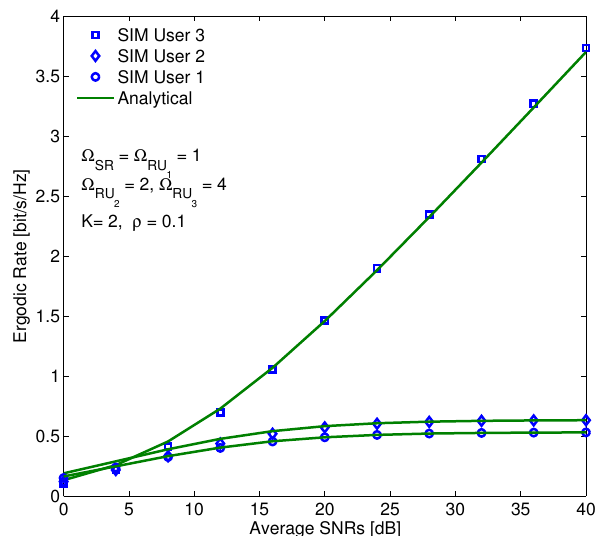
Figure 10. Compare the ER of users in each cluster for the perfect SIC with η = 0.85, a 1 = 0.6, a 2 = 0.3, a 3 =